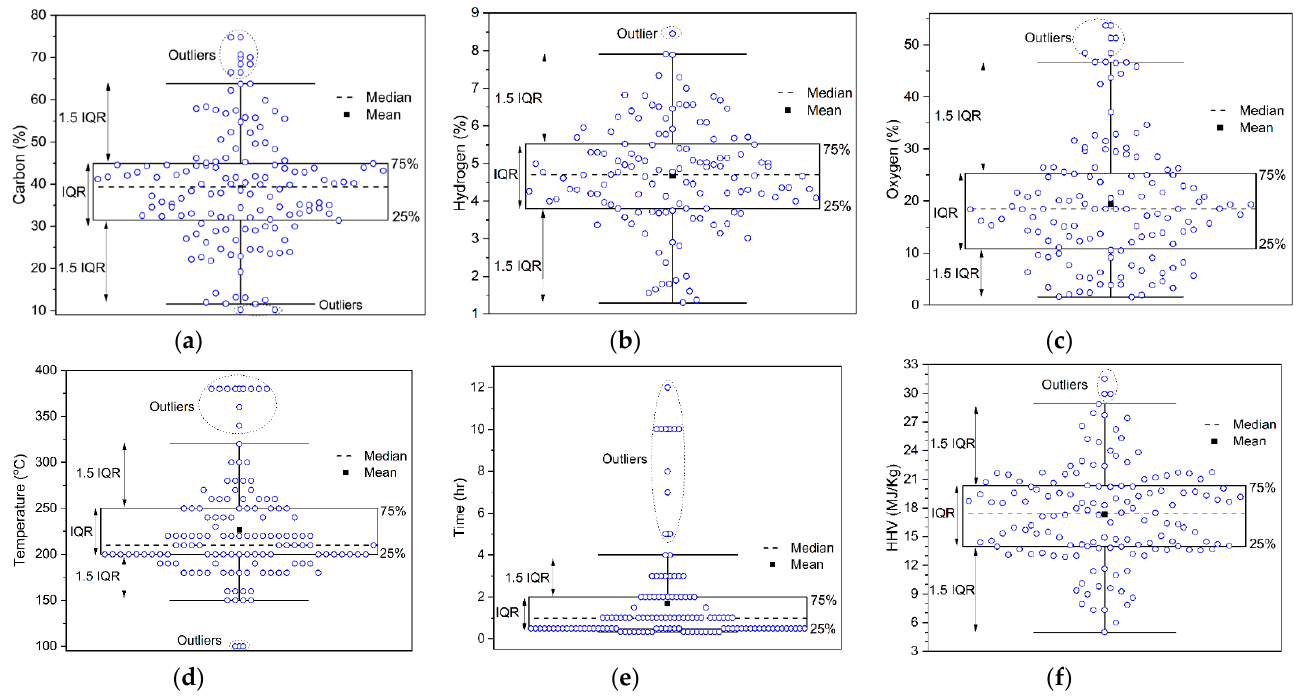
Figure 2. Box and whisker plots of the values related to SSHs’ composition variables (carbon ( a ), hydrogen ( b ), oxygen ( c ), temperature ( d ), time ( e ), and HHV ( f )). The data of each dataset are represented as blue markers and divided into quartiles. Each plot depicts the minimum value, the first quartile (Q1), the median, the third quartile (Q3), and the maximum value of the dataset (as five bottom to top horizontal lines), and the mean value (as a rectangular marker). The data within the range from Q1 − 1.5IQR to Q3 + 1.5IQR (where IQR = Q3 − Q1) are considered useful, while the data outside this range are rejected as outliers (enclosed inside dotted ellipsoids).